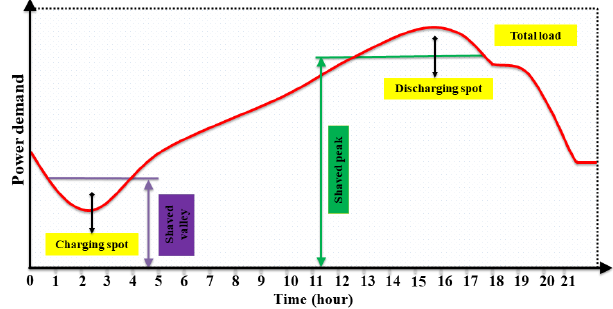
Figure 7. Peak shaving of ESS application [31].